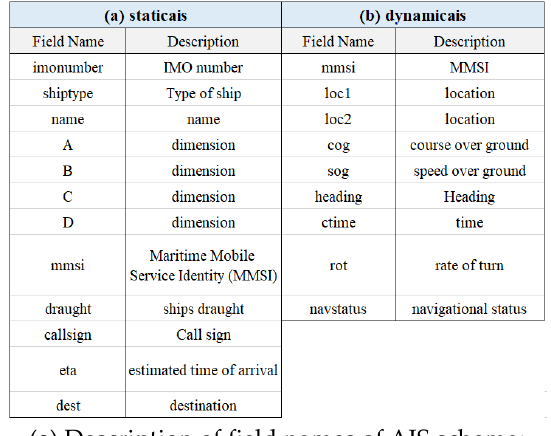
Figure 4. Data Lakehouse schema for AIS, V-Pass, VBD, and Observation data.